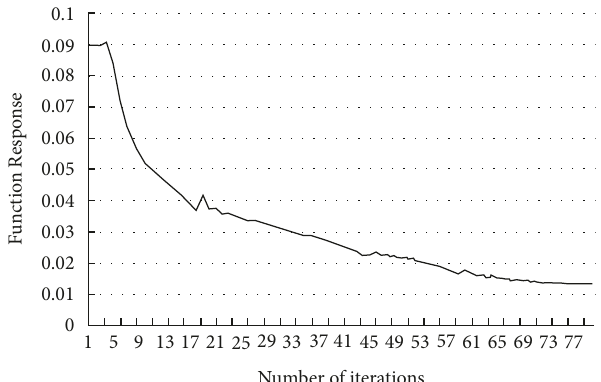
Figure 10: Iterative diagram of the combined function